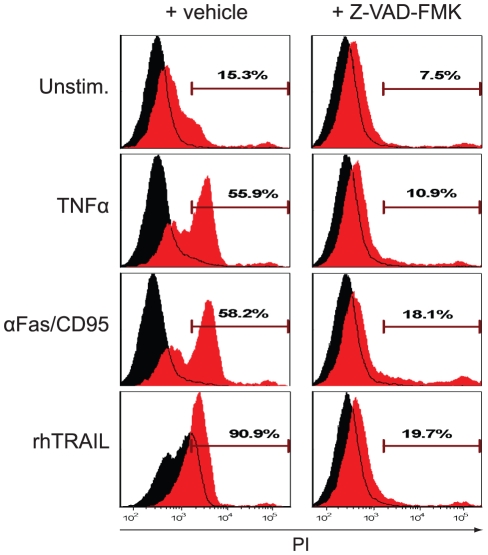
Transfection of HeLa cells with miR-133b results in enhanced caspase-dependent loss of membrane integrity after DR ligation.Cells were transfected with miR-133b alone or together with ctrl miR. After 48 h, cells were left untreated (Unstim) or stimulated for 4 h with either 20 ng/ml TNFα, 100 ng/ml αFas/CD95 or 20 ng/ml rhTRAIL. In order to assess caspase dependency, 0.01% DMSO (vehicle) (left histogram column) or Z-VAD-FMK (50 µM) (right histogram column) were added to the cells. Following stimulation, both adherent and suspension cells were collected, stained with propidium iodide (PI) and analyzed by flow cytometry. Samples were compared to equally treated ctrl miR-transfected cells (black histogram). Results are representative of at least three independent experiments.